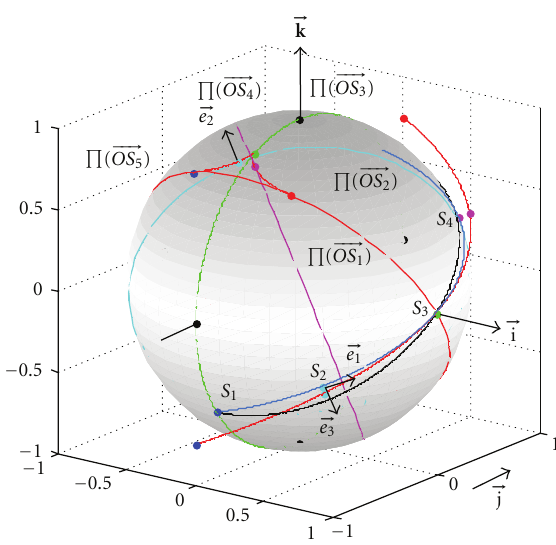
Figure 7: Motion process of the frequency plane. The red curve is a segment of a helical scanning trajectory. The blue curve is its projection on the unit sphere. The black curve is the great circle through S 1 , S 3 , and S 5 . Five positions of the frequency plane are color coded. The points inside the triangle are scanned 3 times while the rest points are scanned only